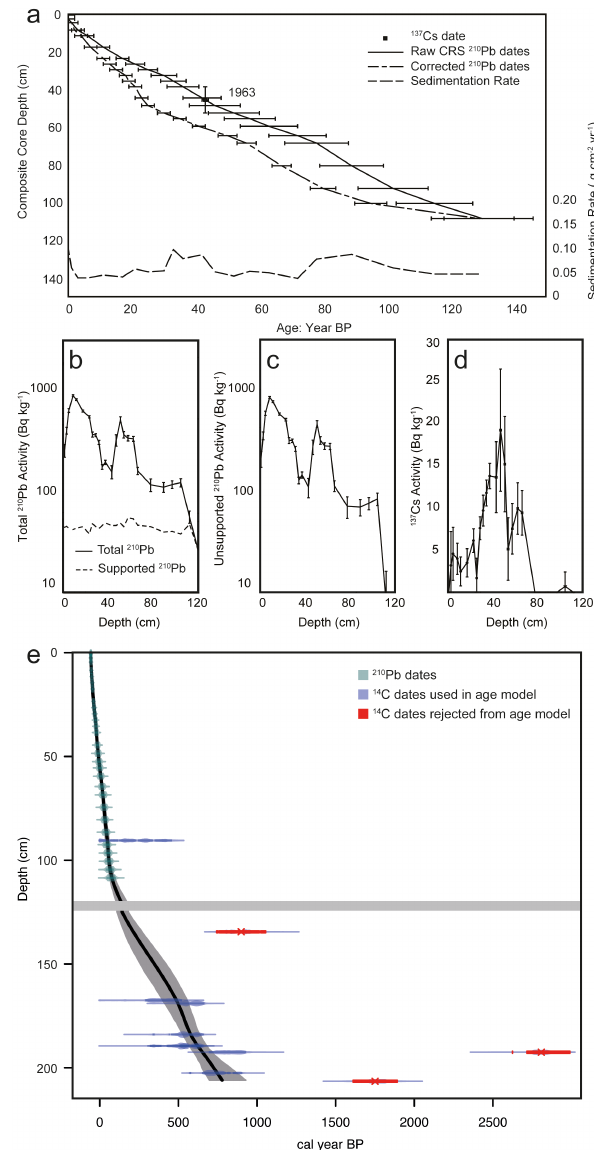
Figure 2. Radiometric dating of the Lake Nyamogusingiri sediment core (a) 210 Pb and 137 Cs chronology and sedimentation rate. Fall- out radionuclides (versus depth) of (b) supported and unsupported 210 Pb, (c) unsupported 210 Pb, (d) 137 Cs concentrations (note that the 210 Pb concentration data is a logarithmic scale), and (e) final age model; the grey envelope highlights the chronological uncer- tainty in the record.